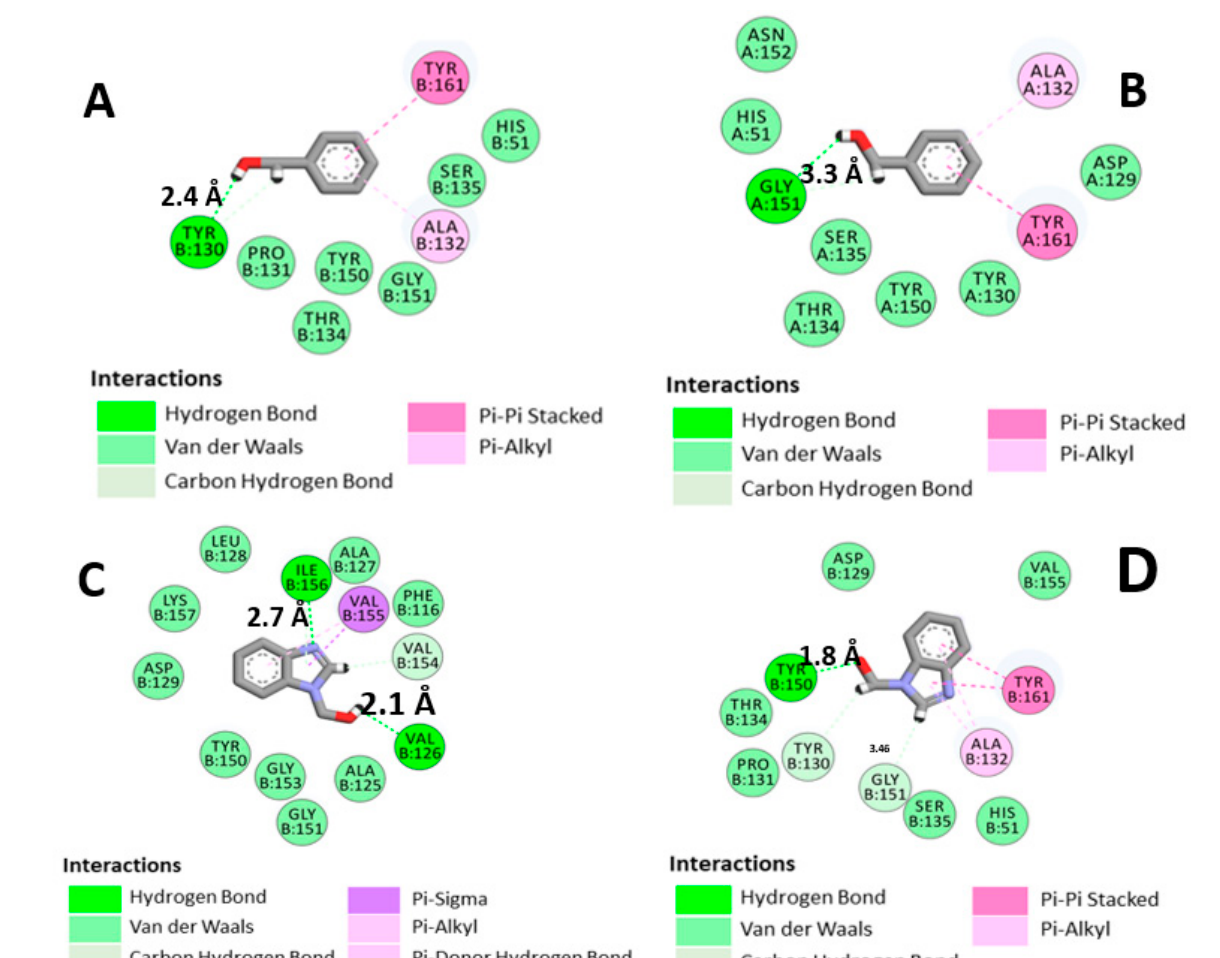
Figure 5. Two-dimensional diagrams of the main interactions of BC and B1Y with the Zika virus protease: ( A ) 5YOD (md5); ( B ) 5YOD (em); ( C ) 5H4I (md5); ( D ) 5H4I (em).